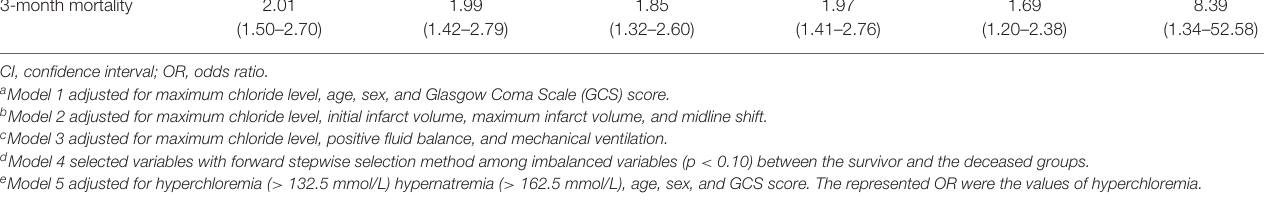
TABLE 4 | Logistic regression analyses for determining the risk factors for acute kidney injury.